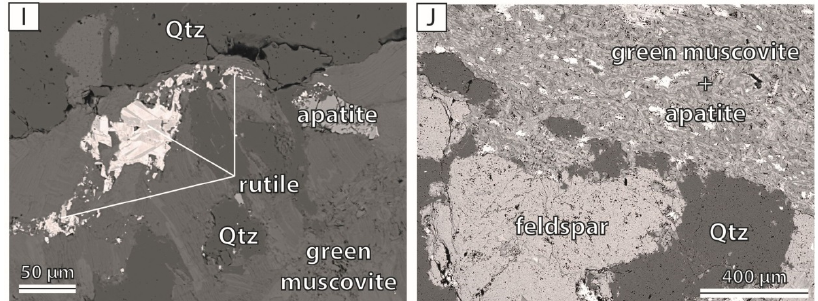
Figure 2. Photomicrographs illustrating greisen assemblage in Beauvoir (images A to H ) and Colettes (images I and J ) granites. ( A ) Backscatter electron (BSE) image of igneous lepidolite and cassiterite partially replaced by hydrothermal muscovite. ( B ) Lepidolite partially replaced by muscovite (BSE). ( C ) Crossed-polarized light (XPL) image of hydrothermal quartz crystalized along muscovite cleavage direction. ( D ) Inclusion of muscovite in hydrothermal quartz (XPL). ( E – G ) Images of the three principal greisen minerals, i.e., quartz, muscovite and apatite, and their textural relationships in several parts of strongly altered Beauvoir granite (BSE). ( H ) An apatite crystal surrounded by muscovite, displaying Sr zoning, visible by light and darker BSE shades. ( I ) Hydrothermal apatite, rutile, muscovite and quartz in geisenized Colettes granite. Quartz in the upper part of the image is a relic of the igneous generation (BSE). ( J ) Hydrothermal muscovite and apatite altering igneous quartz and potassic feldspar relicts (BSE). Coltan = colombo-tantalite. Minerals 2019 , 9 , x FOR PEER REVIEW